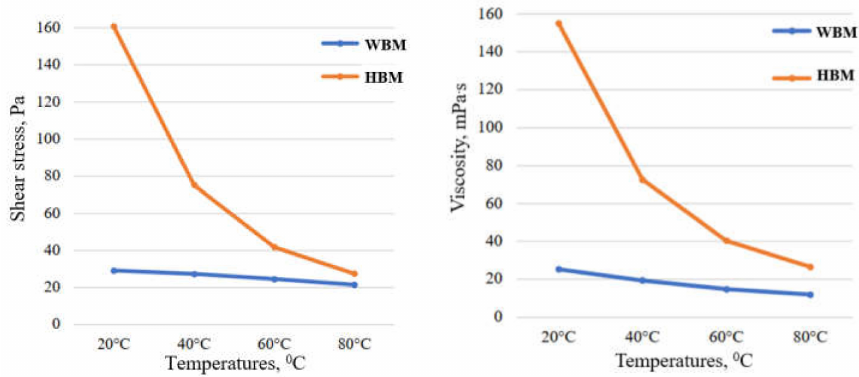
Figure 6. Comparison of the rheology of the investigated solutions at different temperatures.